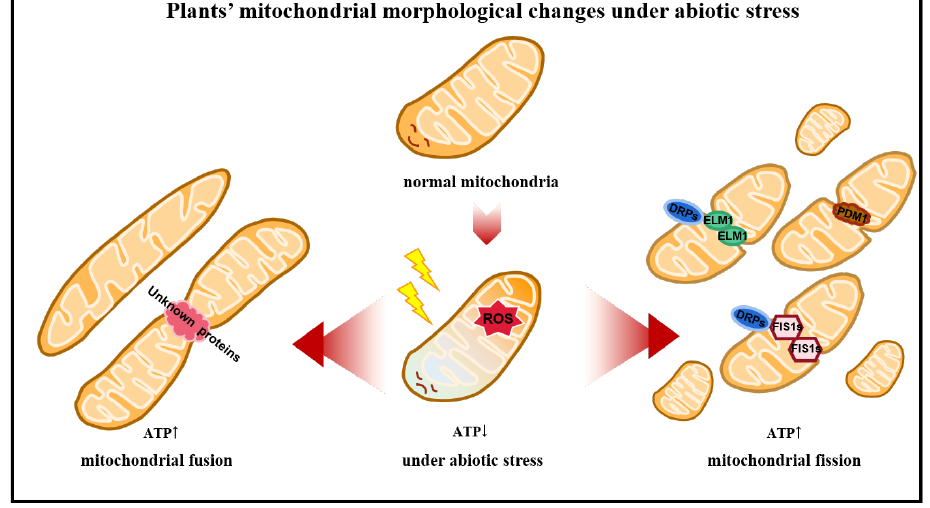
Figure 2. Morphological changes in plant mitochondria under abiotic stress. Image credit: Hui Tang.